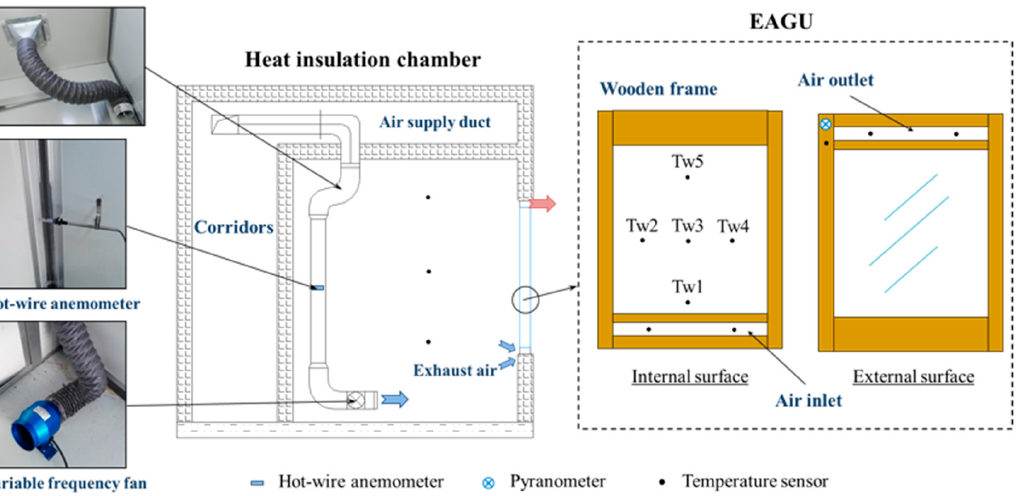
Figure 4. Layout of the measurement facilities [35]. Reprinted with permission from ref. [35]. Copyright 2018